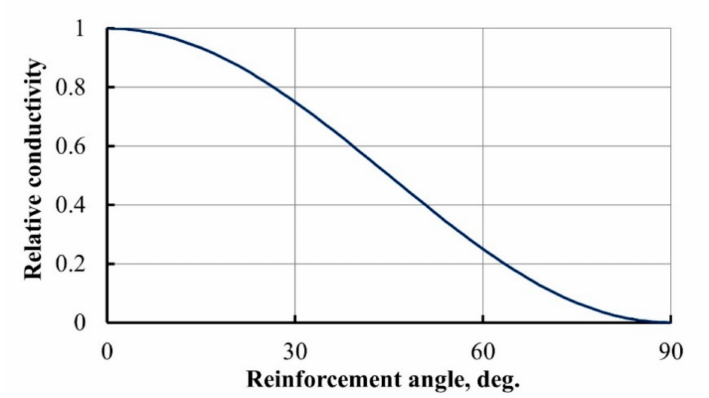
Figure 5. Dependence of relative conductivity on the angle of reinforcement. As composite reinforcement was rotated from longitudinal to the transverse direction, the relative conductivity was changing gradually from 1 to 0, as could be